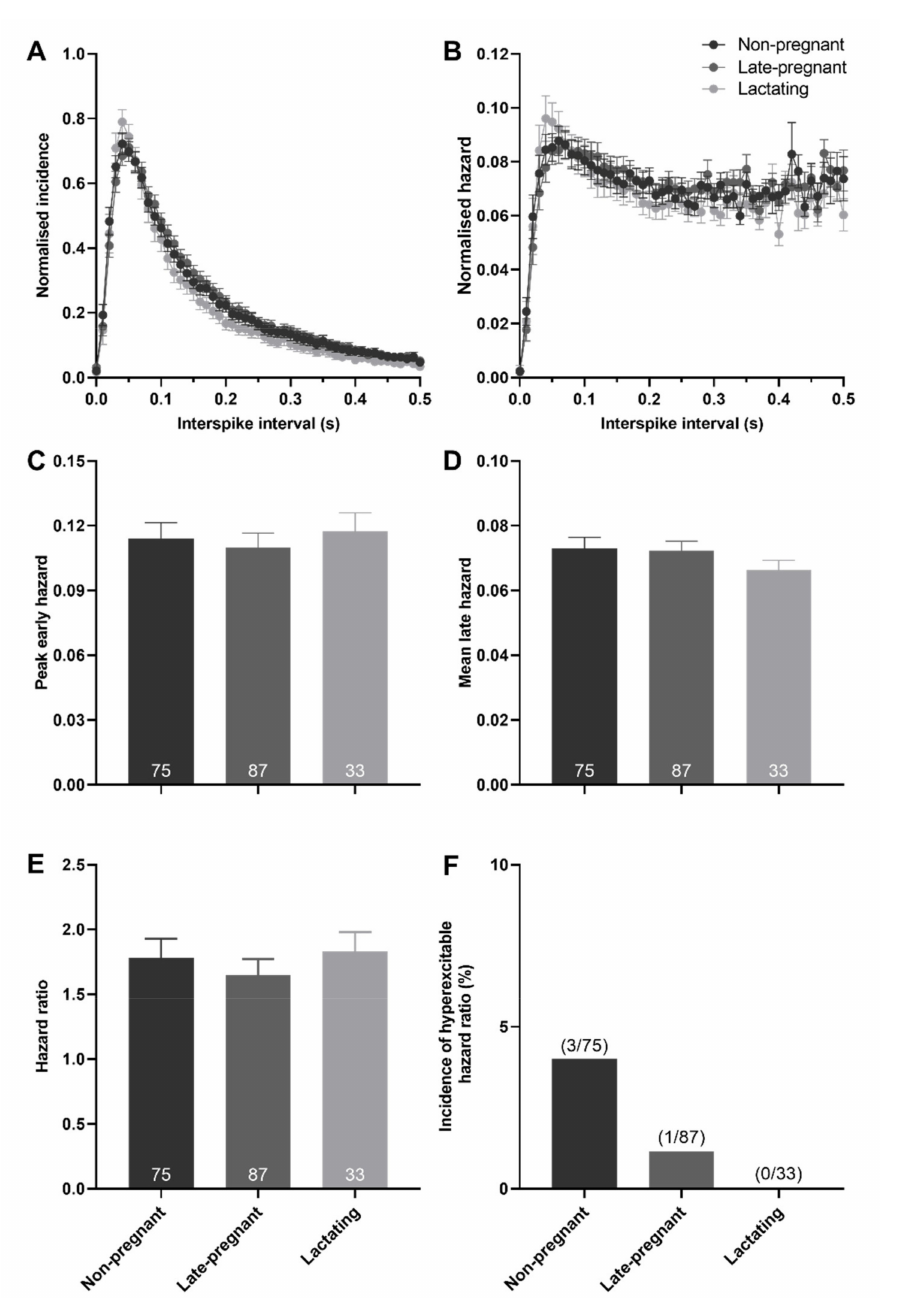
Figure 4. Post-spike excitability in vasopressin neurons in non-pregnant, late-pregnant, and lactating rats. ( A ) Mean ( ± SEM) normalised interspike intervals of basal activity in vasopressin neurons from non-pregnant, late-pregnant, and lactating rats. ( B ) Mean ( ± SEM) normalised hazard functions from the same neurons in ( A ). ( C – E ) Mean ( ± SEM) peak early hazard ( C ), late hazard ( D ), and peak early/mean late hazard ratio ( E ) in vasopressin neurons from non-pregnant, late-pregnant, and lactating rats. There was no effect of reproductive status on the peak early hazard ( H = 0.82, p = 0.66), mean late hazard ( H = 1.81, p = 0.40), or hazard ratio ( H = 4.72, p = 0.09) in vasopressin neurons. ( F ) Proportion of vasopressin neurons with post-spike hyperexcitability in non-pregnant, late-pregnant, and lactating rats. The incidence of post-spike hyperexcitability was not different between vasopressin neurons from non-pregnant, late-pregnant, and lactating rats ( χ 2 = 2.38, p =